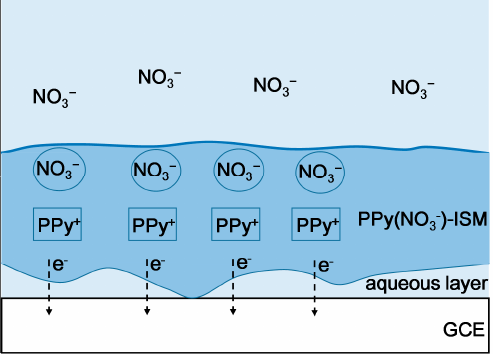
Figure 8. Schematic diagram of the NO 3 − response procedure for the PPy-NS ISE.